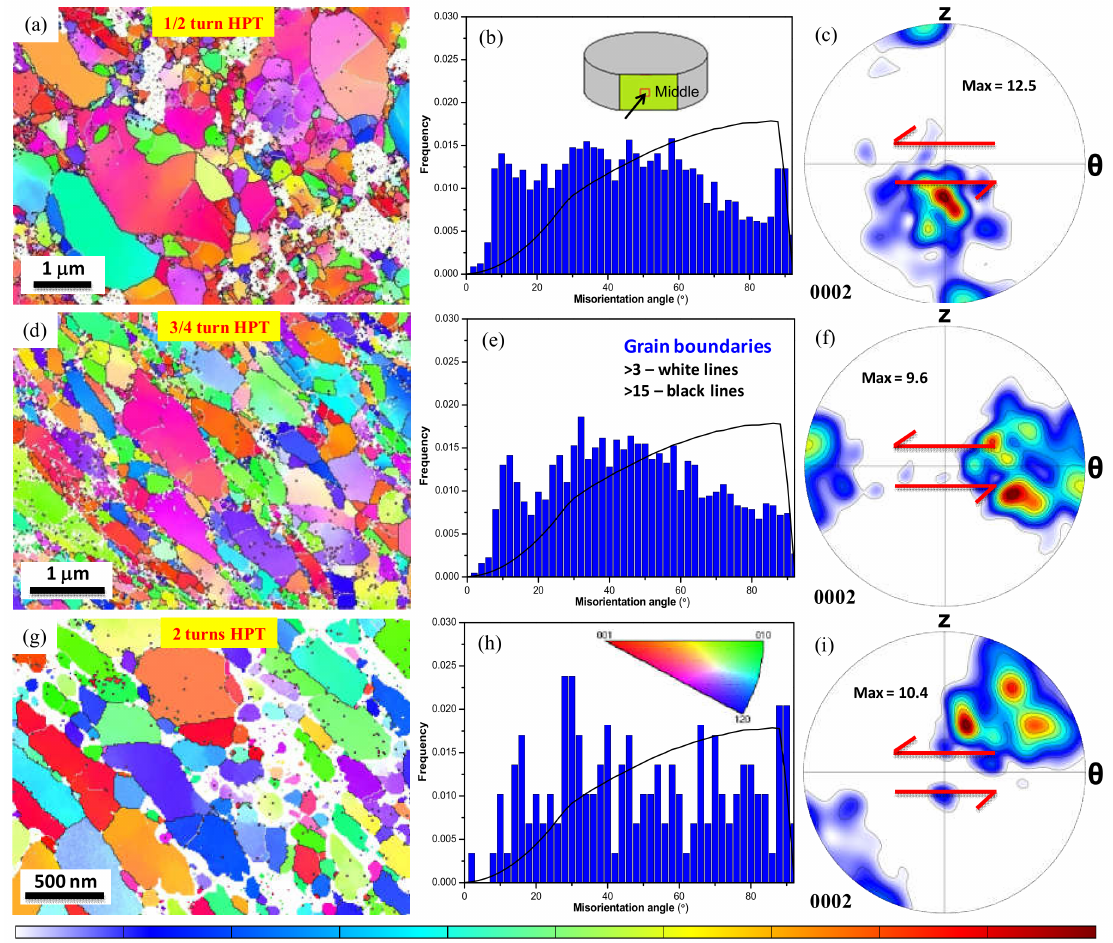
Figure 6. Transmission Kikuchi diffraction (TKD)-based EBSD orientation maps accompanied with grain boundary misorientations and associated microtexture in (0002) pole figure for the 1/2 turn ( a – c ), 3/4 turn ( d – f ), and 2 turns ( g – i ) nano-HPT products, obtained at the outer edge and middle-section of the HPT-disk (see the inset of Figure 6b). Note the differences in scale